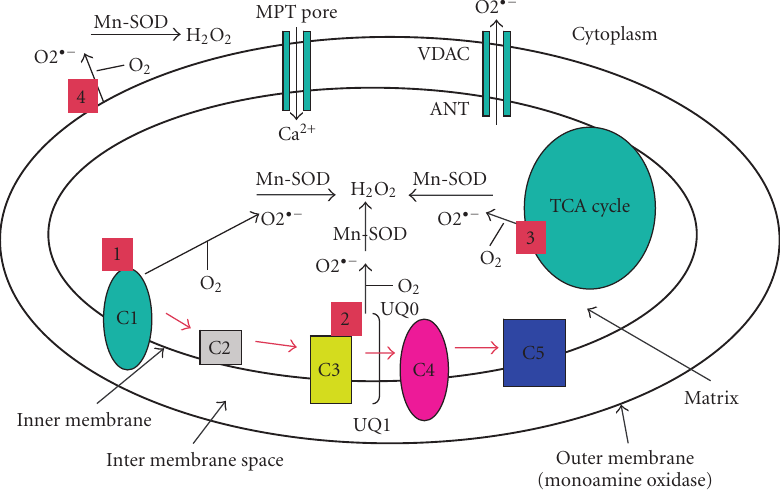
Figure 1: Illustration of sites of free radical generation in the mitochondria. In the respiratory chain, complexes 1 and 3 leak electrons to oxygen, producing primarily superoxide radicals (or O •− 2 ). The O •− 2 are dismutated by manganese superoxide dismutase to generate H 2 O 2 and oxygen. Complex 1 generates O •− 2 only toward the matrix. Complex 3, on the other hand, generates O •− 2 toward both the intermembrane space and the matrix. The components of tricarboxylic acid, including α -ketoglutarate dehydrogenase, also generate O •− 2 in the matrix. Free radicals are generated in the outer mitochondrial membrane (monoamine oxidase) and catalyze the oxidative deamination of primary aromatic amines, leading to the generation of H 2 O 2